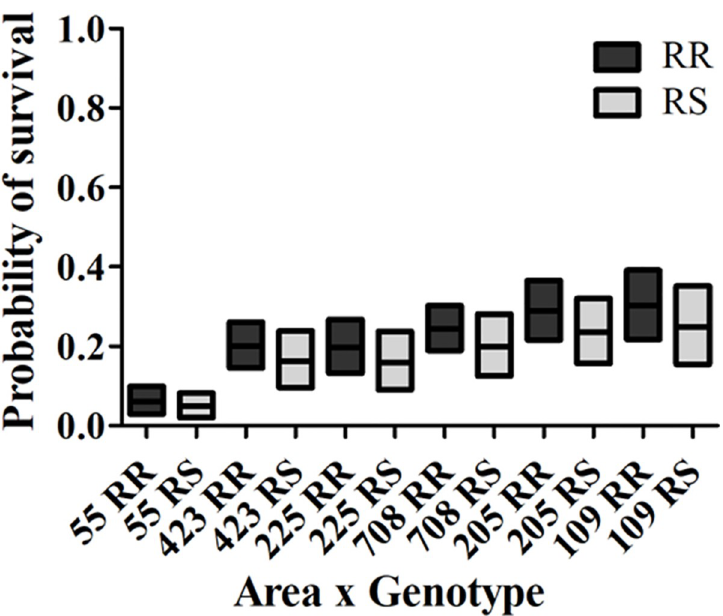
Fig 11. Survival probability of kdr homozygous and heterozygous resistant Cx . quinquefasciatus from the 6 areas. The boxes’ middle lines represent the predicted probability of survival obtained by logistic regression analysis. The top and bottom values of the boxes are the upper and lower confidence intervals (CIs) (S1 Table). The overall model fit (logistic regression, P < 0.0001).